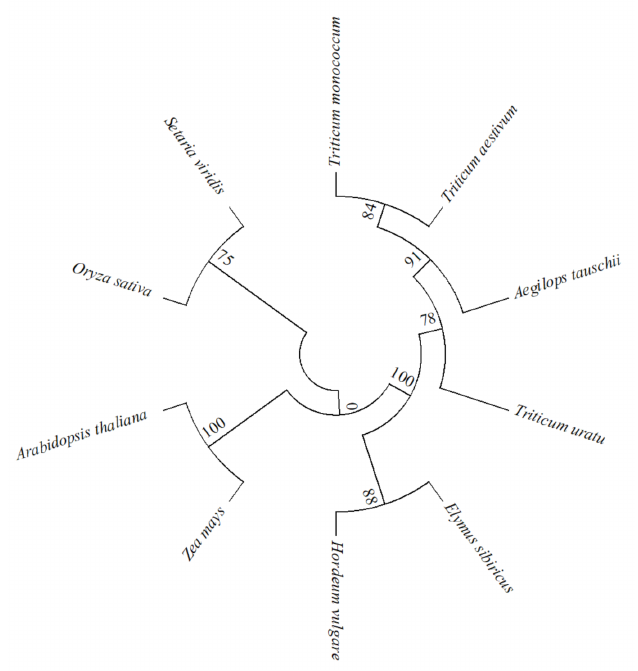
Figure 3. Genetic relationship analysis based on EsABI5 protein. We found 10 proteins that interacted with EsABI5 (credibility score > 0.7; Figure 4). The B3 domain containing the protein VP1 (VP1B3) had a credibility score of 0.916, which is the best functional partner of the EsABI5 protein. Two of these proteins were uncharacterized (UP); the others were ABA-inducible protein kinase (ABAIPK), CBL-interacting protein kinase 22 (CIPK22), WD repeat-containing protein DWA1 (DWA1WD), CBL-interacting protein kinase 29 (CIPK29), E3 ubiquitin-protein ligase KEG (KEGE3), serine/threonine- protein kinase SAPK8 (SAPK8), and serine/threonine-protein kinase SAPK3 (SAPK3). All of these functional interacting proteins play regulatory roles in plant stress.